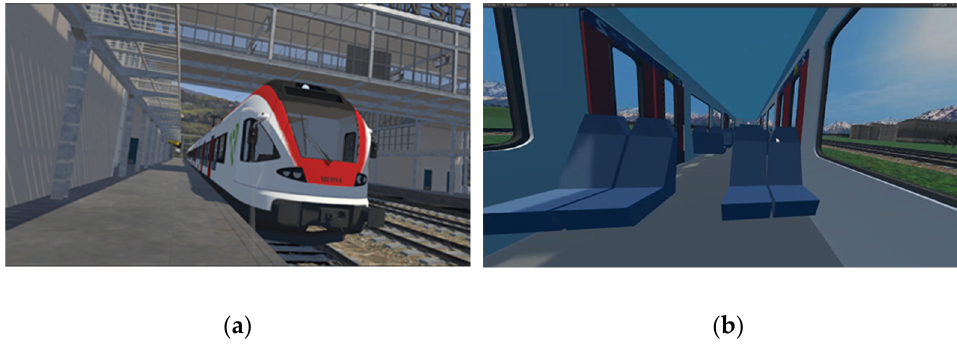
Figure 5. Train scenario: ( a ) train station and ( b ) inside the train.